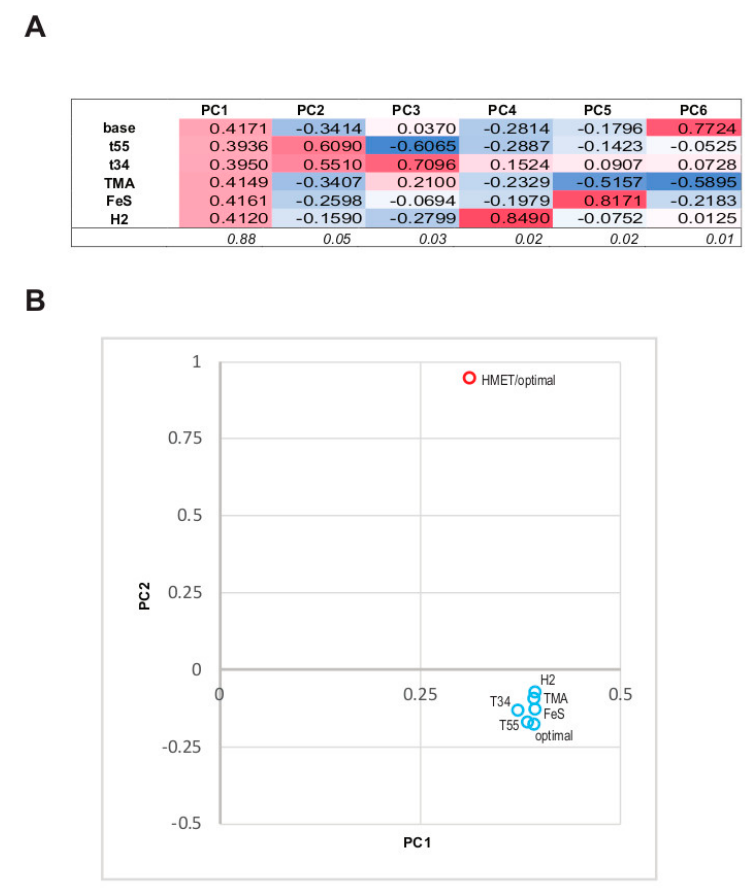
Figure 3. Statistical analysis of the protein abundance space. ( A ) Principal Component (PC1-PC6) loadings. The colour scale highlights the sing and the magnitude of the contributions of the individual abundance profiles to the Principal Components. ( B ) Comparison of the abundance of “ Candidatus Methanohalarchaeum thermophilum” HMET1 proteins under optimal conditions with all six conditions tested for M. thermophilum AMET1. Data points represent the six M. thermophilum AMET1 profiles and the HMET1 profile, plotted against the first two Principal Components.